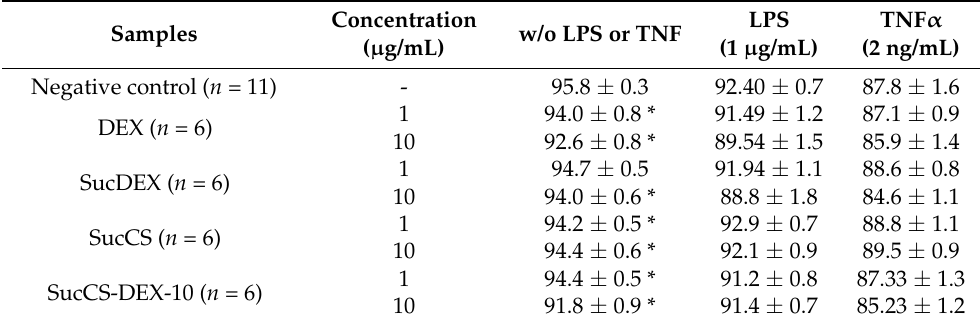
Table 4. The influence of DEX, SucDEX, SucCS, and SucCS-DEX-10 solutions on THP-1 cell viability under inflammatory conditions (mean ±